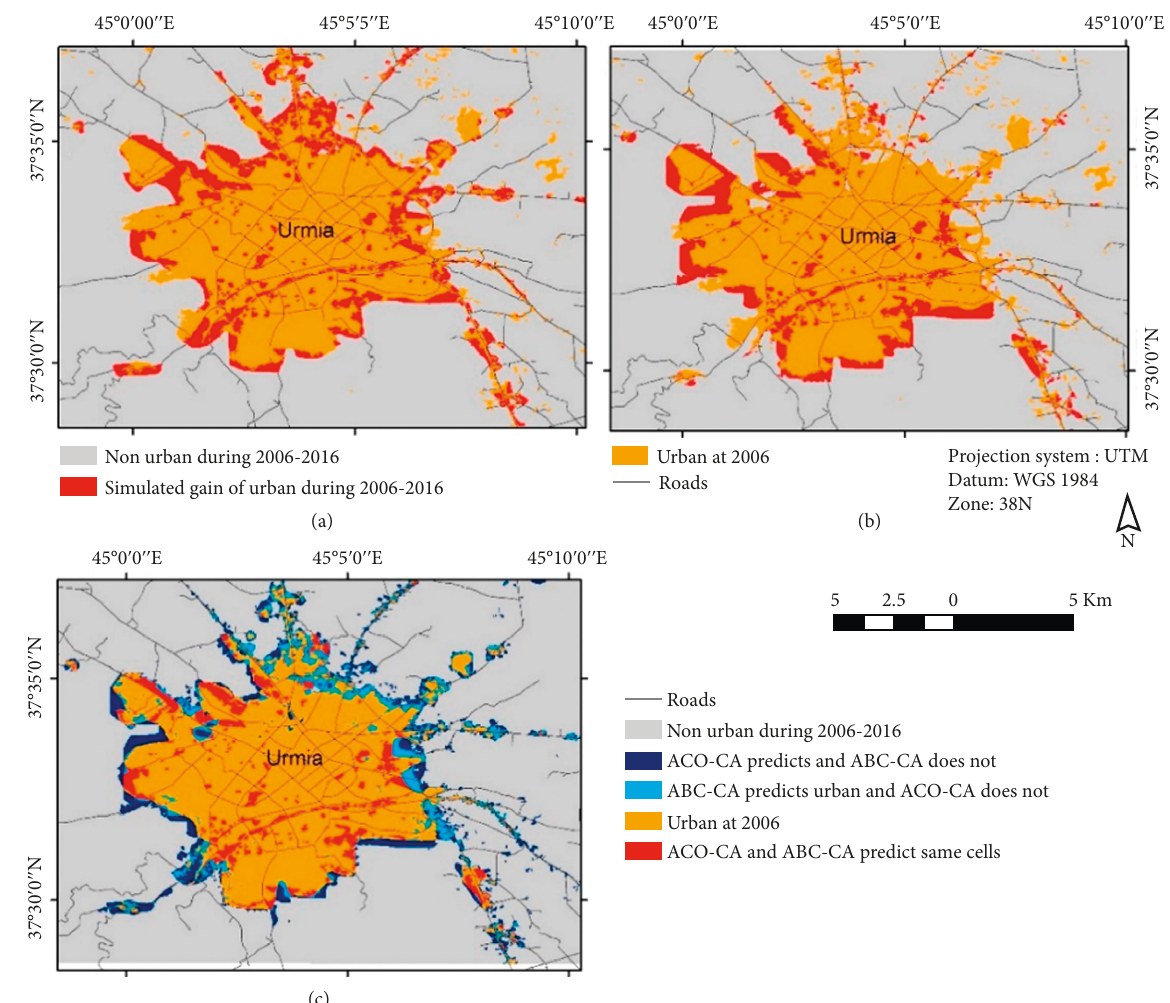
Figure 1: Results of Urmia town prediction for 2016. (a) ABC-CA model; (b) ACO-CA model; and (c) ACO-CA and ABC-CA models’ comparison